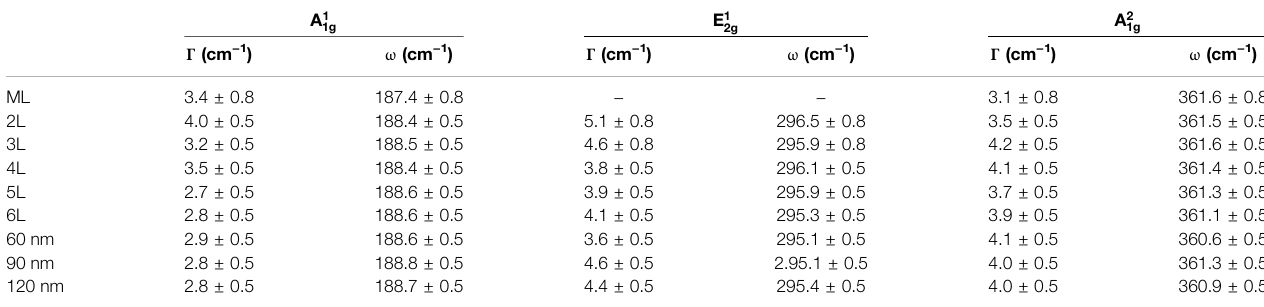
TABLE 1 | Raman shifts ( ω ) and FWHM ( Γ ) for the three modes A 1 1 g , E 1 2 g , and A 2 1 g measured for GaS layers with thickness ranging from monolayer to 120 nm. The 633-nm laser excitation was used. A 1 1g E 1 2g A 2